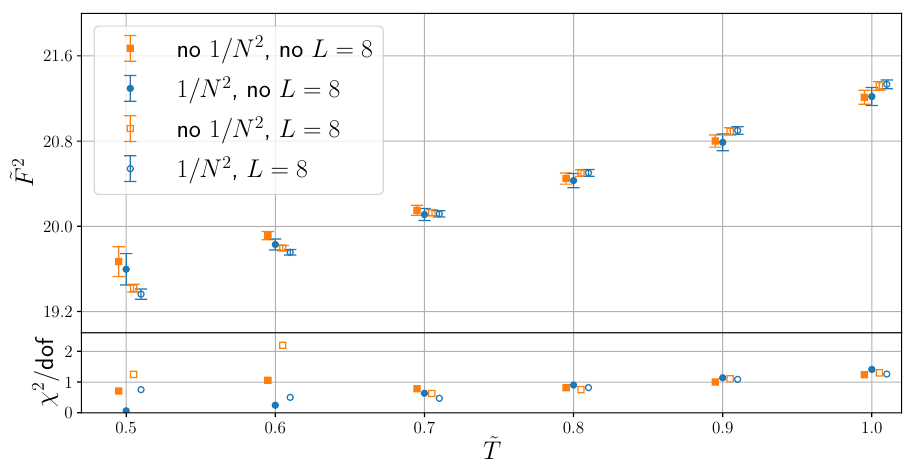
Figure 14. The values of ~ F 2 in the ungauged theory (and the reduced (cid:31) 2 ) as a function of the temperature from di(cid:11)erent simultaneous large- N and continuum extrapolations: with and without 1 =N 2 corrections and with and without L = 8 data points. The error bars of the individual points at (cid:12)xed N , L and ~ T used in the extrapolations have been increased by a factor of four.